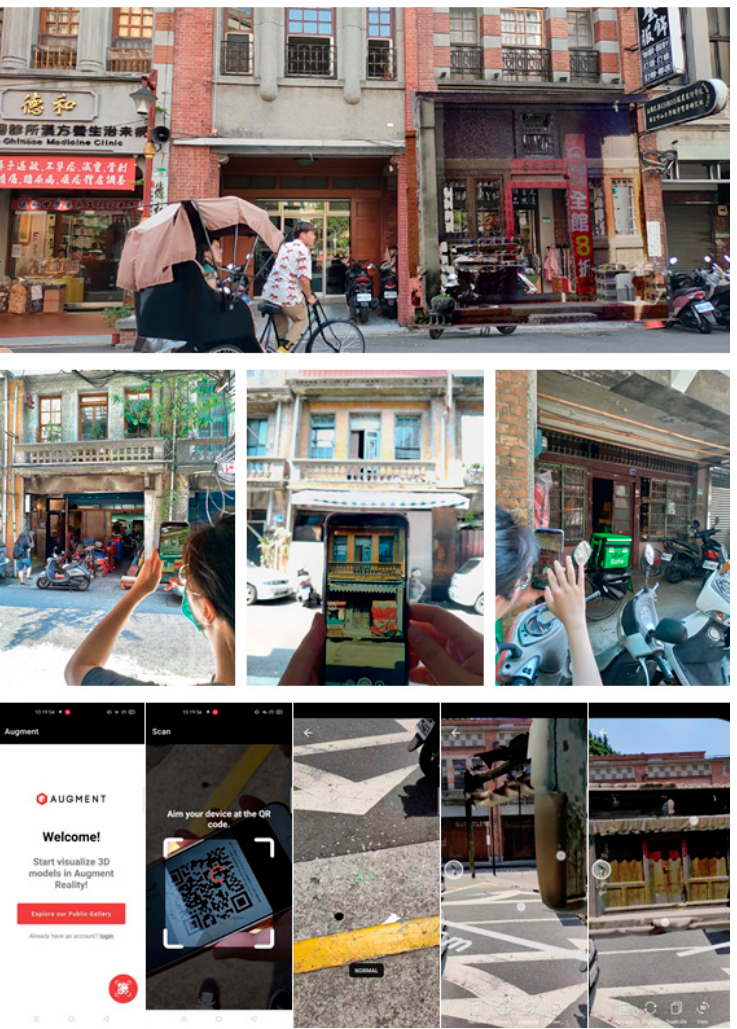
Figure 11. The screen shot ( top ), third-person photographs ( middle ), and the stepwise operation process: launch app, scan QR code of a selected 3D model, detect plane, tap to allocate the model, and adjust the model’s scale, location, or rotation angles ( bottom ).